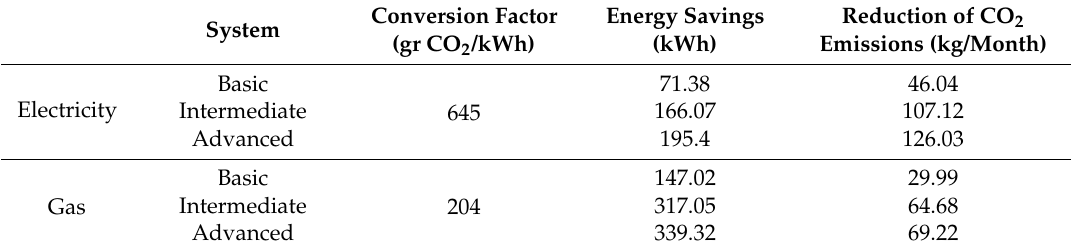
Table 17. CO 2 emissions results.